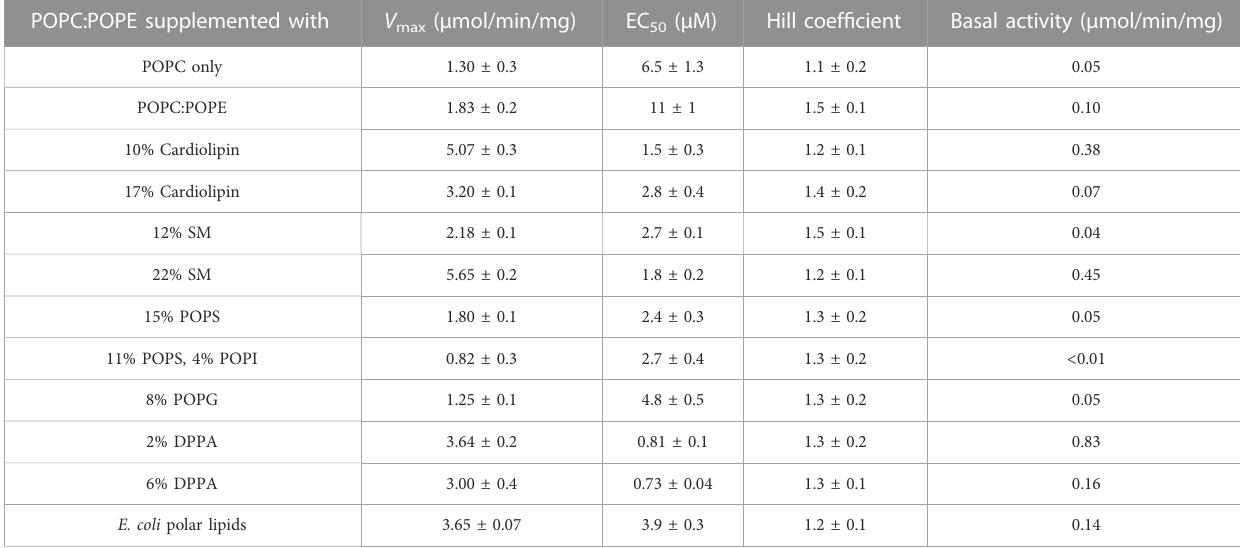
TABLE 2 POPC:POPE (50:50, w/w) was supplemented with indicated phospholipids and the verapamil stimulation of ATPase activity was assayed ( n = 3). POPC:POPE supplemented